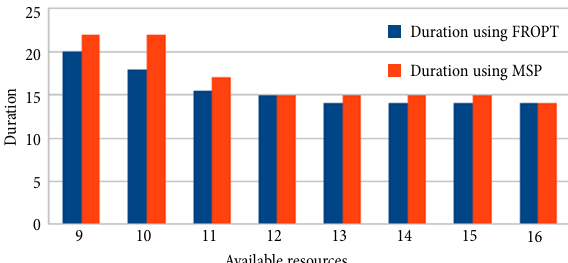
Fig. 4. A comparison of the results obtained using MSP and FROPT for various amounts of available resources for network